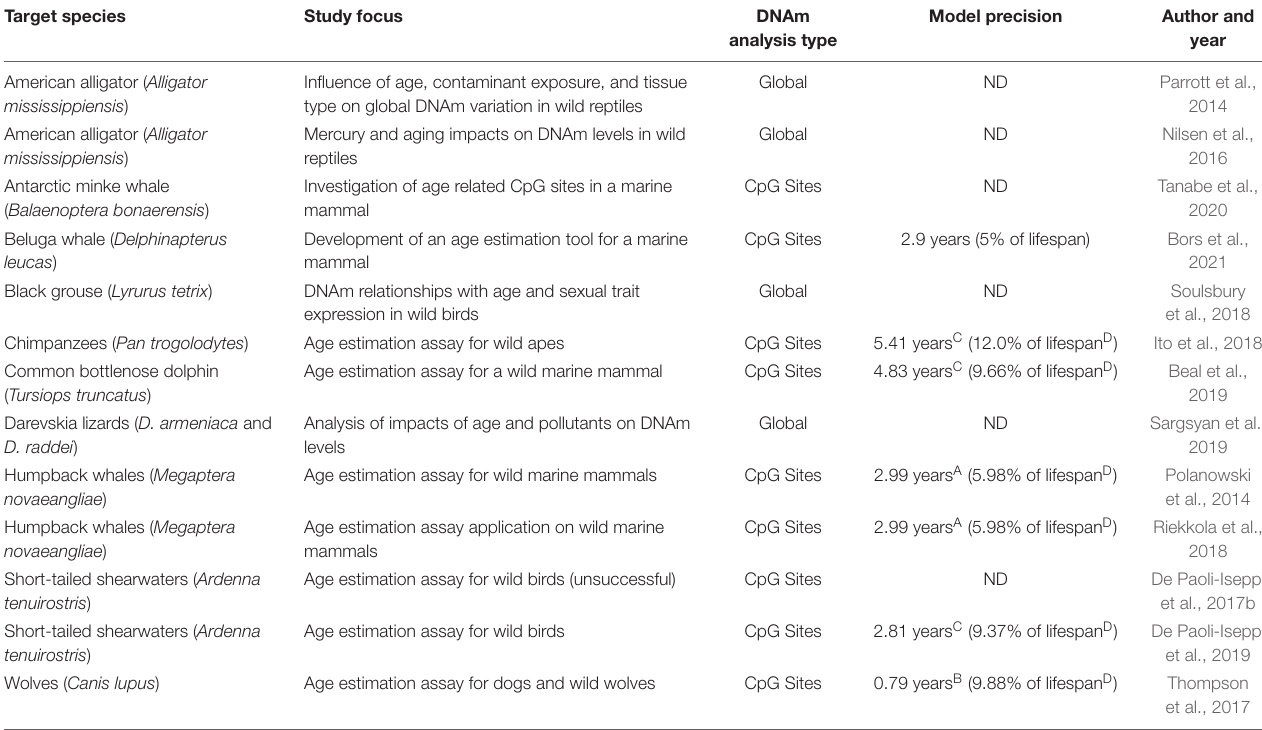
TABLE 1 | DNAm and age associated studies on wild